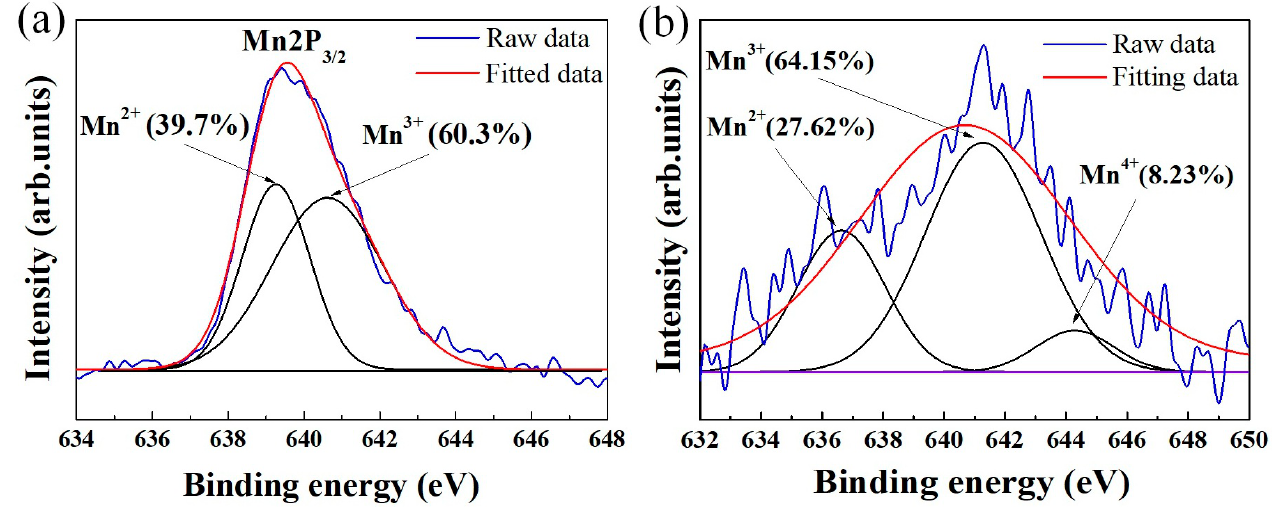
Figure 4. XPS spectra of Mn2p 3/2 for different powder states ( a ) as-prepared and ( b ) calcined at 300 °C.